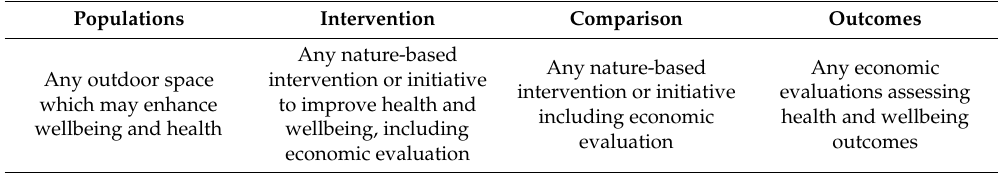
Table A1. Patient / Problem or Population, Intervention, Comparator and Outcome(s) (PICO) framework for mixed methods search